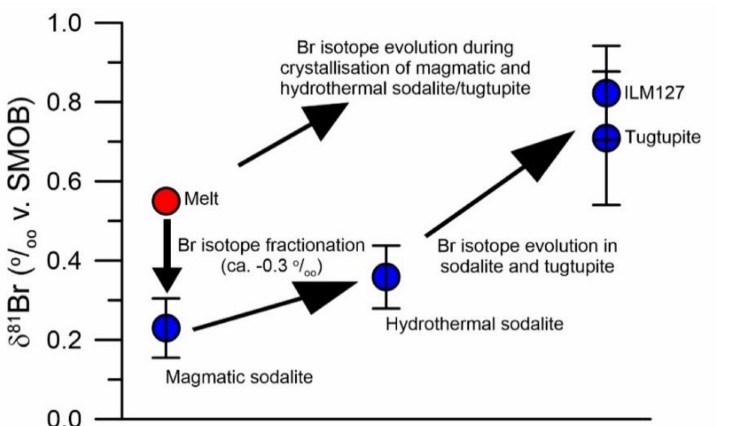
Figure 2. Schematic view of Br isotope evolution from magmatic sodalite, via hydrothermal sodalite to tugtupite (and ILM127). The lithospheric mantle from which the Il í maussaq melt was sourced has a value of +0.5 to 0.6‰, from which magmatic sodalite crystallised with a fractionation factor of about − 0.3‰, giving it the average measured δ 81 Br of +0.23‰. Because light 79 Br is preferentially removed from the fluid phases, the δ 81 Br of the residue increases, which leads to higher δ 81 Br values in sodalite that later crystallised. This evolution continues to the last stages resulting in tugtupite (and perhaps sodalite from fluids that do not contain enough Br to crystallise tugtupite from) with the highest δ 81 Br